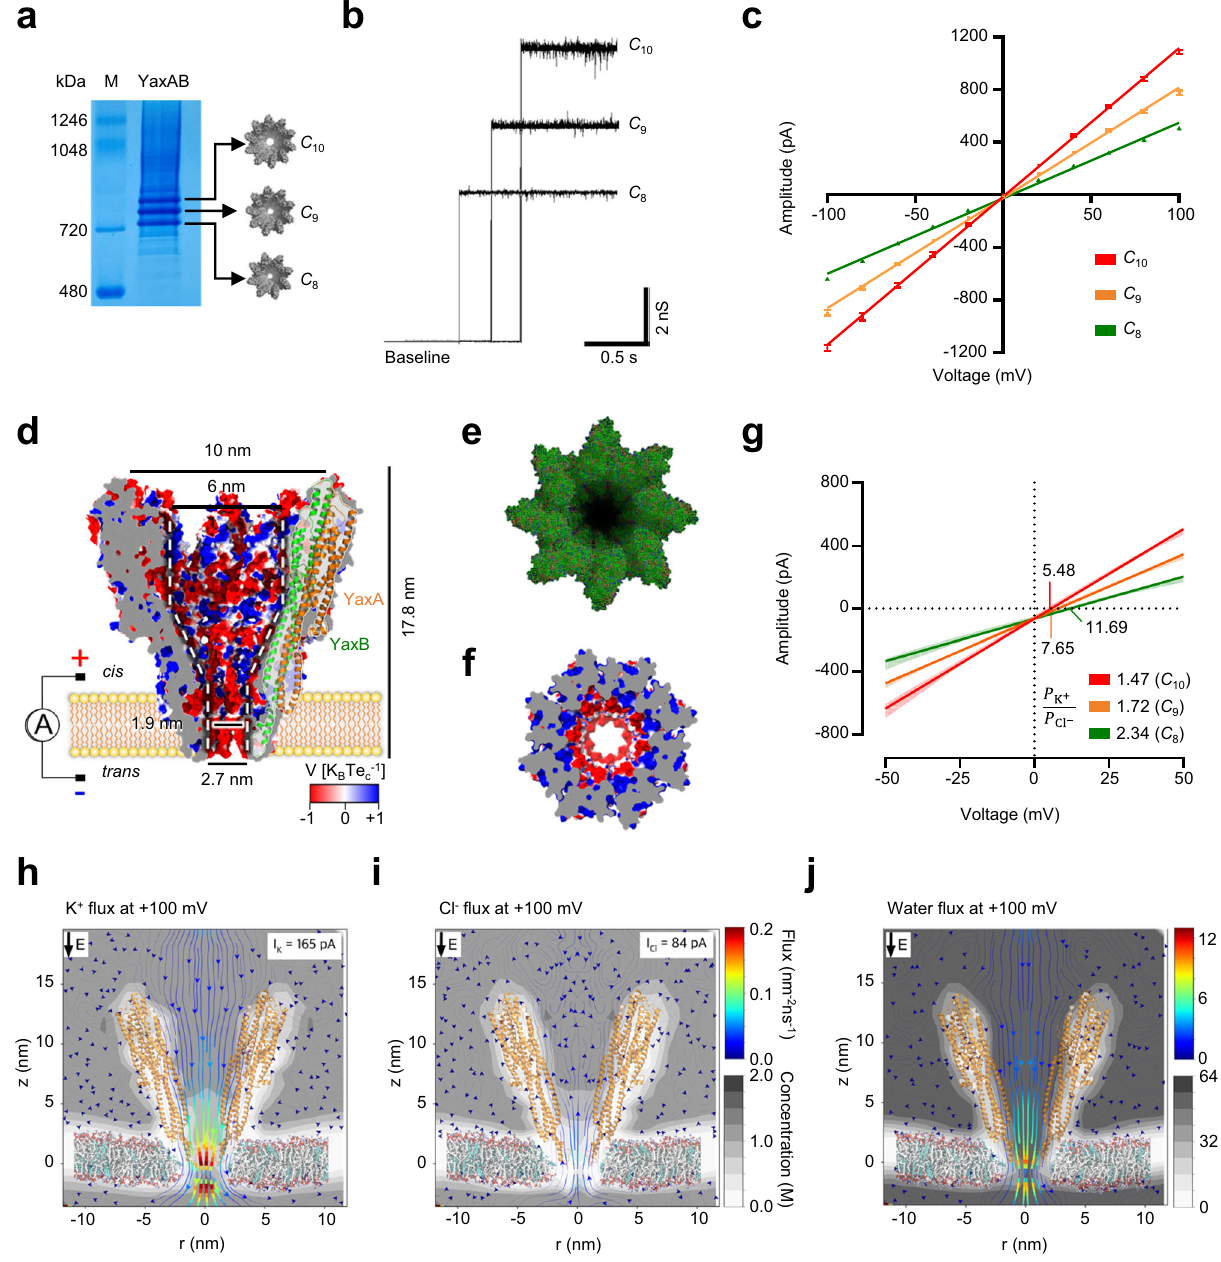
Fig. 1 | Characterization of YaxAB nanopores. Blue native gel (4 – 16%) electro- surfaceclosetotheconstriction( f ). g Reversalpotential,showingcationselectivity for all YaxABnanopores. The reversalpotential values are11.7±0.1mV (YaxAB- C 8 ), phoresis( a )andsingleporeinsertions( b )ofYaxAB- C 8 ,- C 9 ,and- C 10 nanopores.The representative PAGE result is presented, n =3 independent replicates. Source data 7.7±0.7mV (YaxAB- C 9 ), and 5.5±0.1mV (YaxAB- C 10 ). All reversal potentials were measured under asymmetric salt conditions (2M KCl on the trans side and are provided in the Source Data fi le. c Current-voltage (I-V) plots of YaxAB- C 8 (green), - C 9 (orange), and - C 10 (red) nanopores. Data are presented as mean±SD, n =6 independent replicates for YaxAB- n =3 independent replicates for YaxAB- C 8 ; n =9 independent replicates for YaxAB- C C 9 ; 10 . Source data are provided as a Source Data fi le. d Cross section of YaxAB- C 8 nanopore with an overlaying illu- strated representation of a YaxAB heterodimer. The electrostatic potential of the surfaceiscomputedbytheadaptivePoisson-BoltzmannsolveratpH7.5in1MKCl. The funnel-shaped geometry of the inner surface is shown as white dotted lines. Pore lumen, corrugated with convex 8 α -helices ( e ) and negatively charged inner